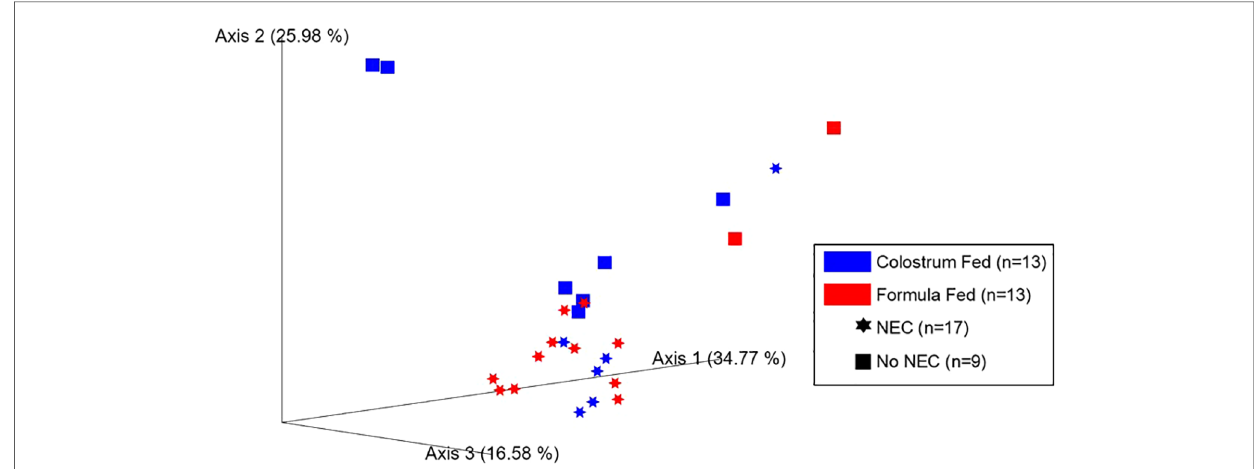
FIGURE 6 Microbial beta diversity in piglet colonic contents. Principal coordinate analysis (PCoA) plot of beta diversity clustering based on feeding regimen ( p =0.019, PERMANOVA using 999 randomizations of the data) and occurrence of NEC ( p =0.002, PERMANOVA using 999 randomizations of the data) derived from the weighted UniFrac distance